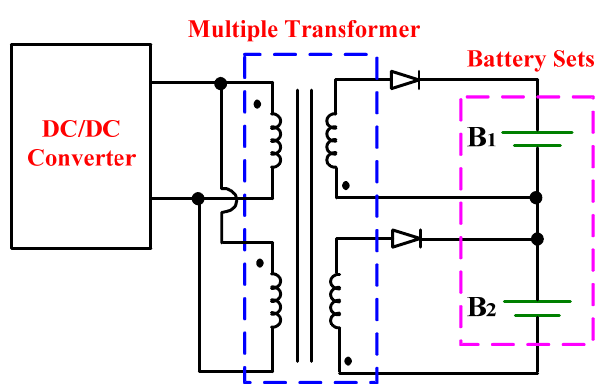
Figure 3. Equalization circuit of multiple transformers.